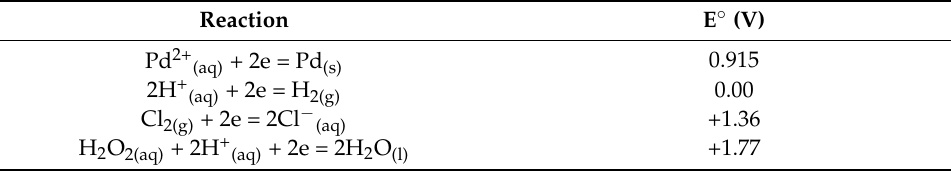
Table 2. Standard reduction potentials of some constituents at 25 ◦ C